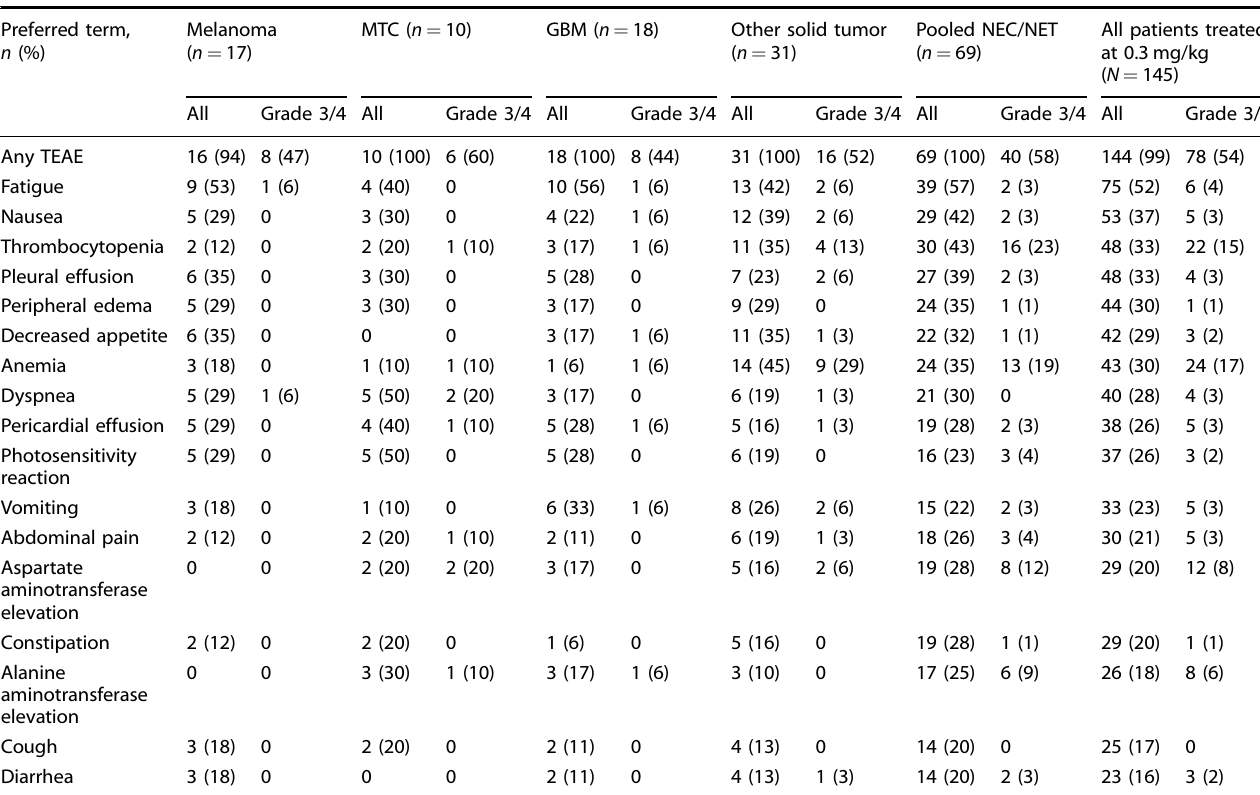
Table 3. TEAEs in >15% at any grade in all patients treated at the 0.3-mg/kg dose. Preferred term, n (%)